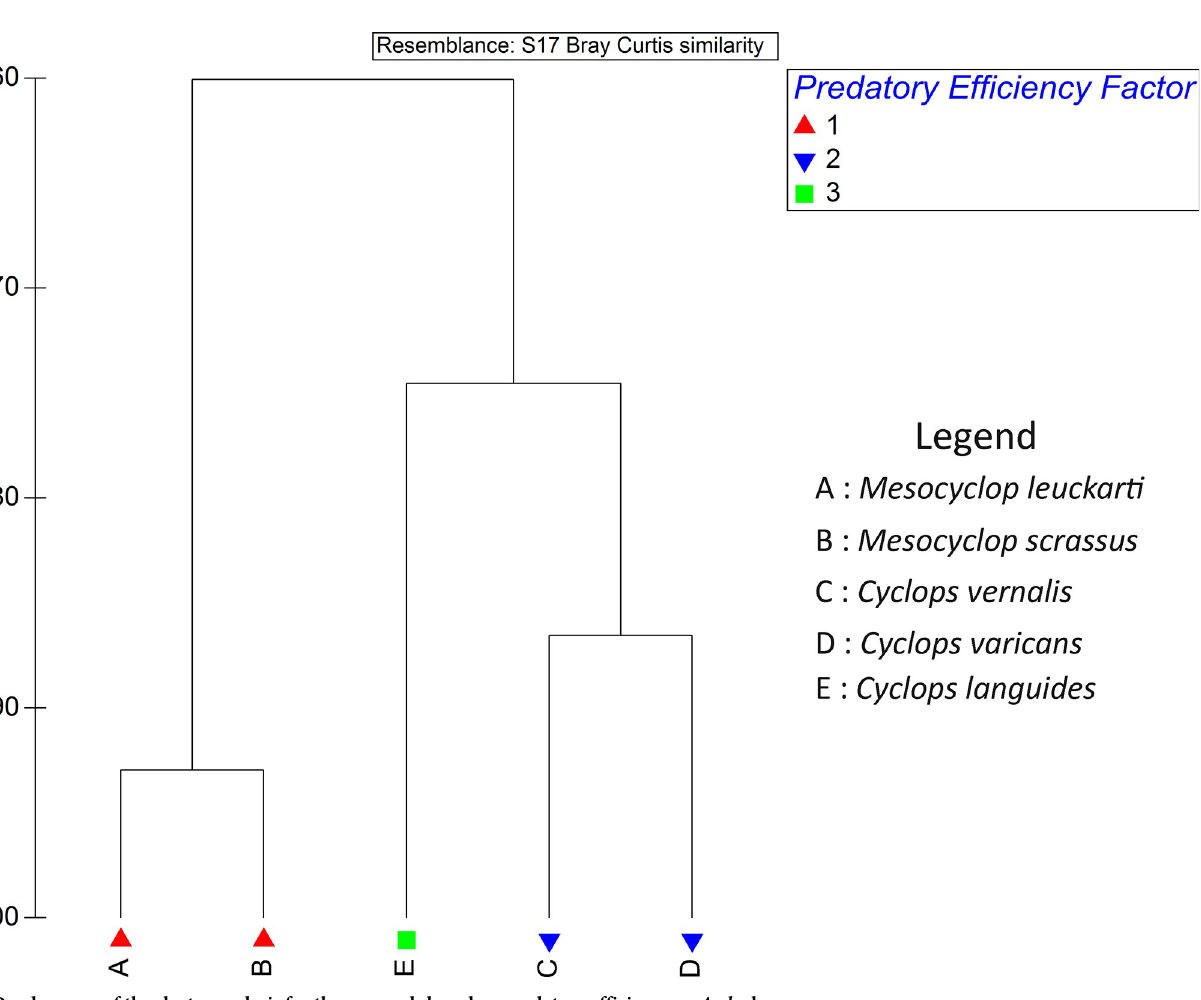
PLOS ONE | https://doi.org/10.1371/journal.pone.0216140 May 28,